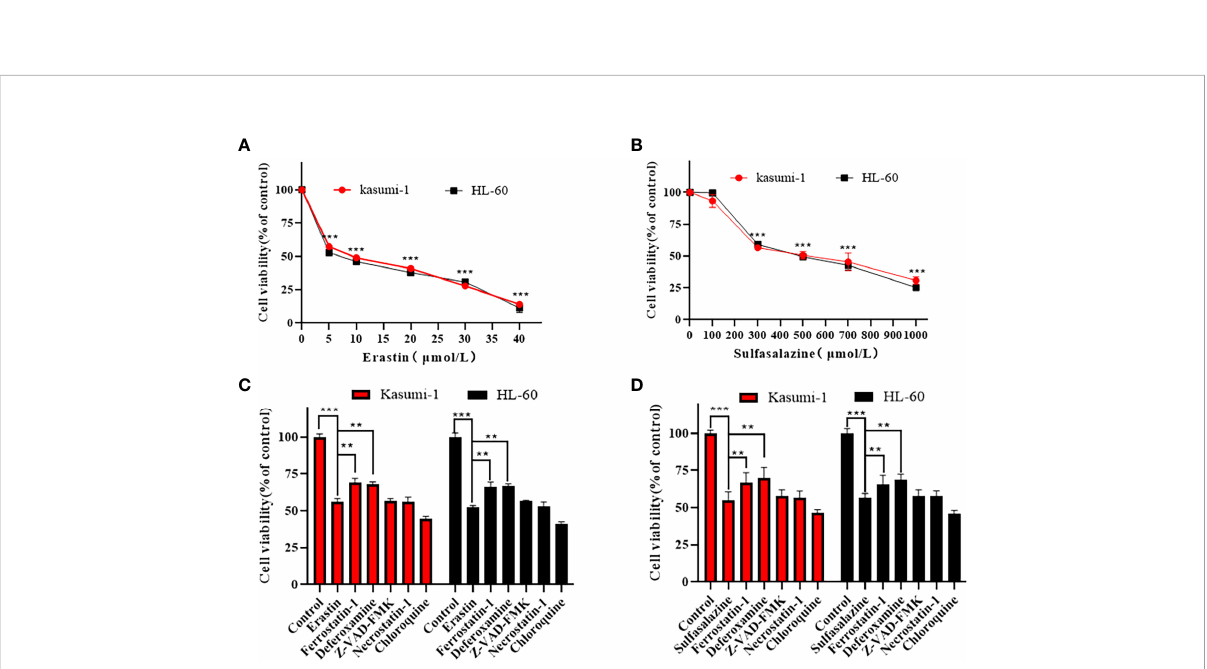
FIGURE 6 Erastin and sulfasalazine induce ferroptosis in Kasumi-1 and HL-60 cells. (A) The viability of Kasumi-1 and HL-60 cells treated with different concentrations of erastin for 24 h was determined using the MTS method. (B) The viability of Kasumi-1 and HL-60 cells treated with different concentrations of sulfasalazine for 24 h was determined using the MTS method. (C) Kasumi-1 and HL-60 cells treated with normal or 5µM erastin were cultured with Ferrostatin-1(2 µM), deferoxamine (100 µM), necrostatin-1 (10 µM), Z-VAD-FMK (10 µM) or chloroquine (25 µM) for 24 h, and cell viability was detected using the MTS assay. (D) Kasumi-1 and HL-60 cells treated with normal or 300µM sulfasalazine were cultured with Ferrostatin-1(2 µM), deferoxamine (100 µM), necrostatin-1 (10 µM), Z-VAD-FMK (10 µM) or chloroquine (25 µM) for 24 h, and cell viability was detected using the MTS assay. ** P < 0.01; *** P <